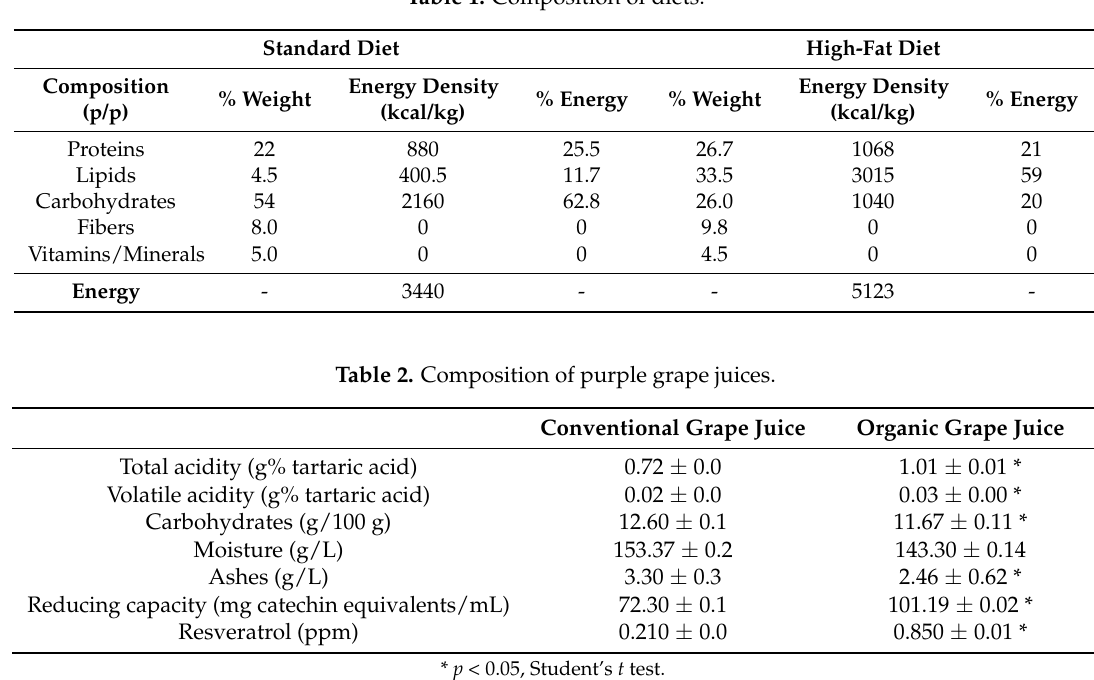
Table 1. Composition of diets.